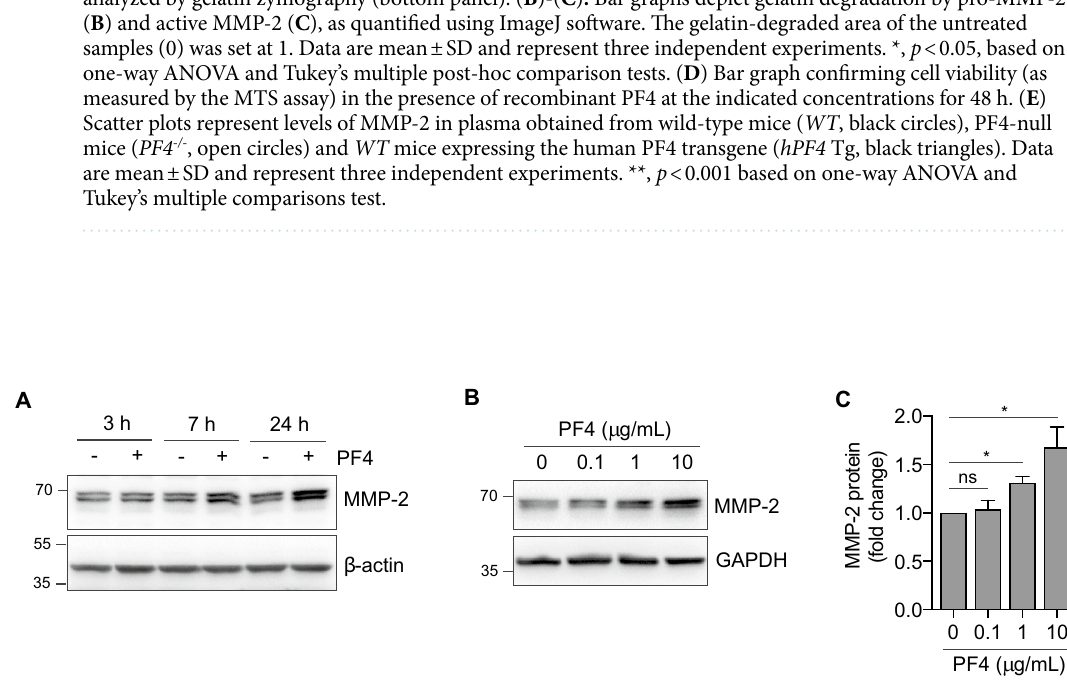
Figure 2. PF4 induces MMP-2 protein production. ( A ) Serum-starved hGFs were cultured in the absence (−) or presence (+) of recombinant PF4 (10 μg/mL) for the time periods indicated. Equal amounts of protein from cell lysates were resolved by SDS-PAGE and immunoblotted with antibodies against MMP-2 and beta-actin (β-actin). ( B ) Serum-starved cells were cultured in the absence (−) presence (+) of recombinant PF4 for 24 h at the concentrations indicated. Equal amounts of protein from cell lysates were resolved by SDS-PAGE and immunoblotted with an antibody against MMP-2. GAPDH is shown as a loading control. ( C ) Bar graph depicts the quantification of intracellular MMP-2 in PF4-treated cells, based on the immunoblots represented in ( B ). The ratio of MMP/GAPDH of the untreated sample (0) was set at 1. Data are mean ± SD and represent three independent experiments. *, p < 0.05, based on one-way ANOVA and Tukey’s post-hoc multiple comparison